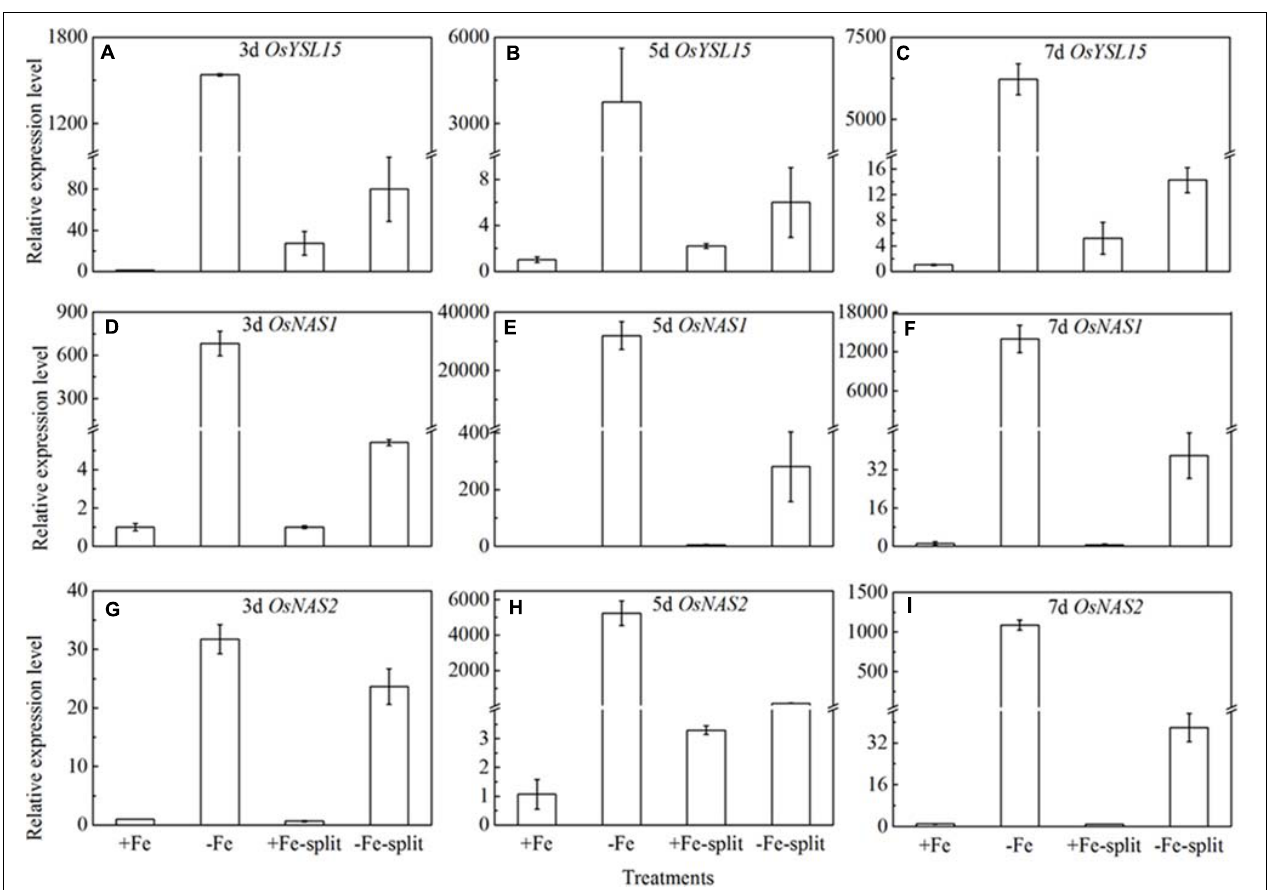
FIGURE 8 | Expression levels of OsYSL15, OsNAS1 and OsNAS2 in rice root of the split root experiment. The part labels in figures indicate the expression levels of different genes after different days (3, 5, and 7) of iron deficiency treatment. (A–C) Expression levels of OsYSL15 at 3, 5, and 7 days; (D–F) Expression levels of OsNAS1 at 3, 5, and 7 days; (G–I) Expression levels of OsNAS2 at 3, 5, and 7 days. Data are presented as means ± SE of three biological